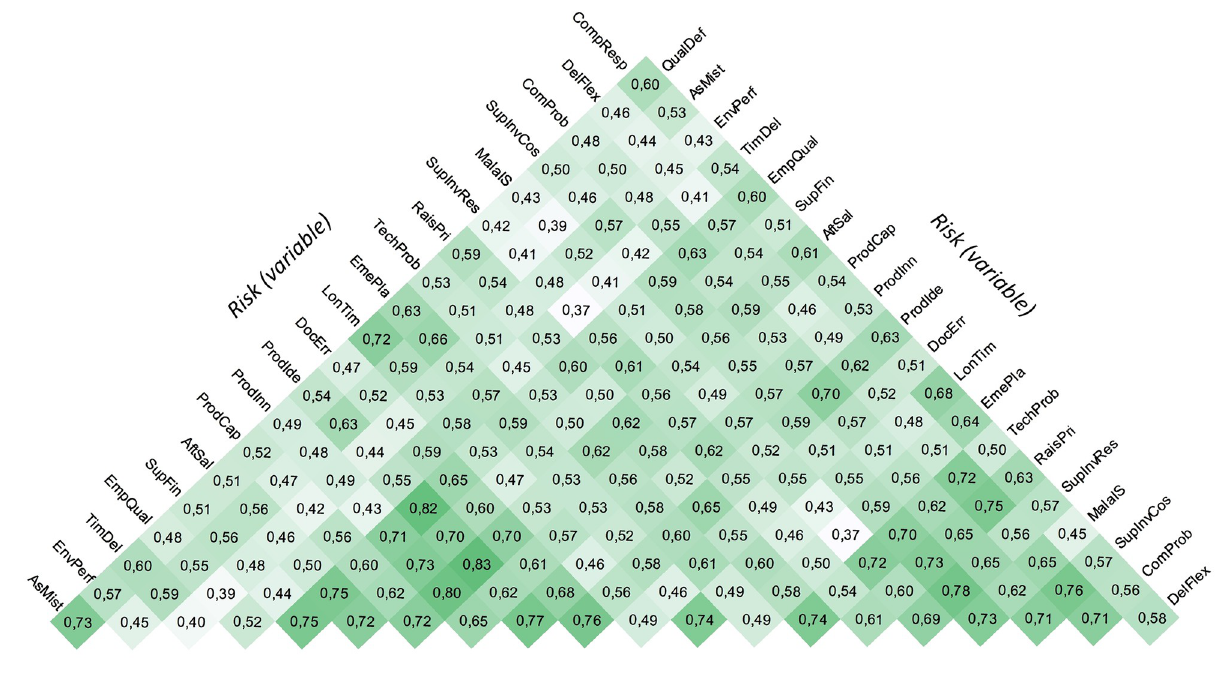
Fig 3. Correlation heatmap (values represents the Pearson linear correlation coefficient).